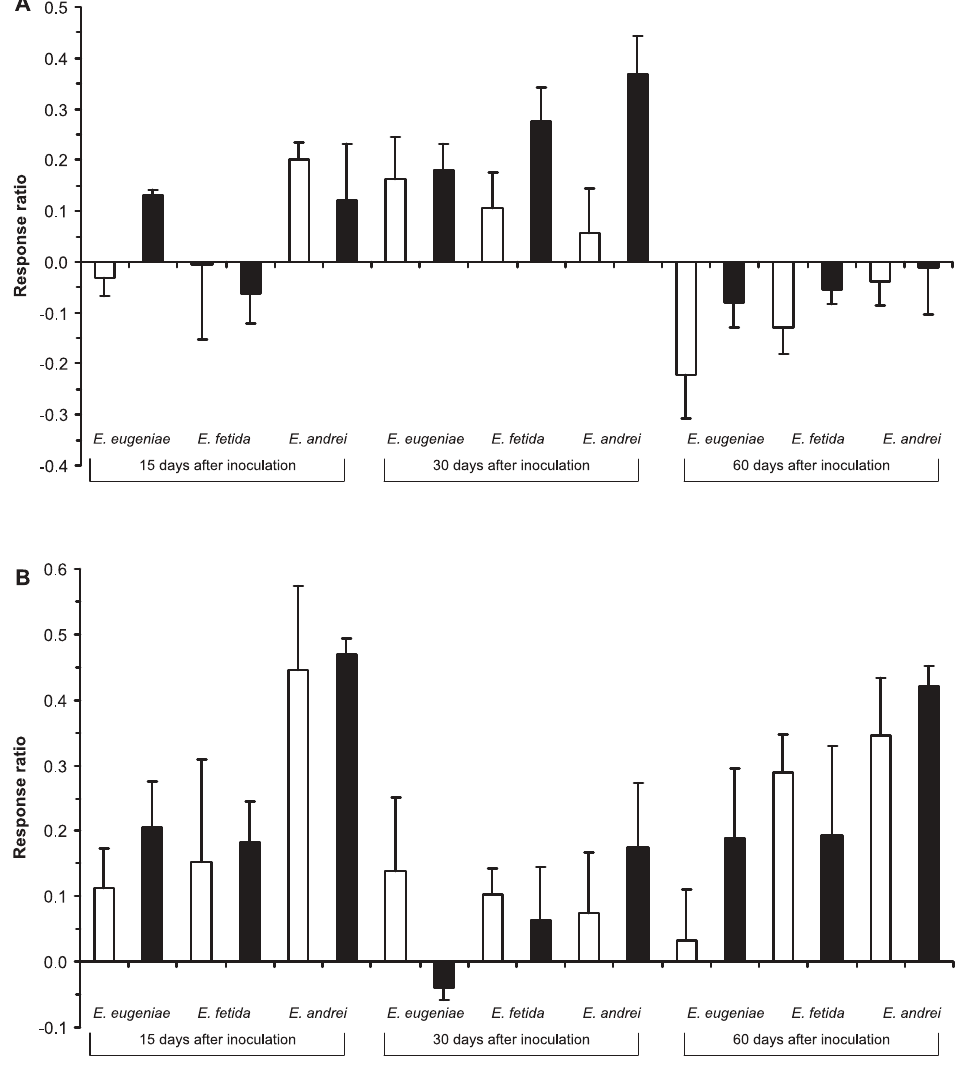
Figure 3. Effects of type of vermicompost, dose of inoculation and time on P and N metabolism. Shown are the changes in the a) alkaline phosphatase and b) protease activity in presence of inoculum of vermicompost (2.5 and 10%) relative to control (no inoculum) calculated as (V i -V c )/ V c , where V i and V c are the values of the variables of samples inoculated with vermicompost or controls. White and black bars represent 2.5 and 10% of inoculation respectively. Mean 6 SE (n=5).